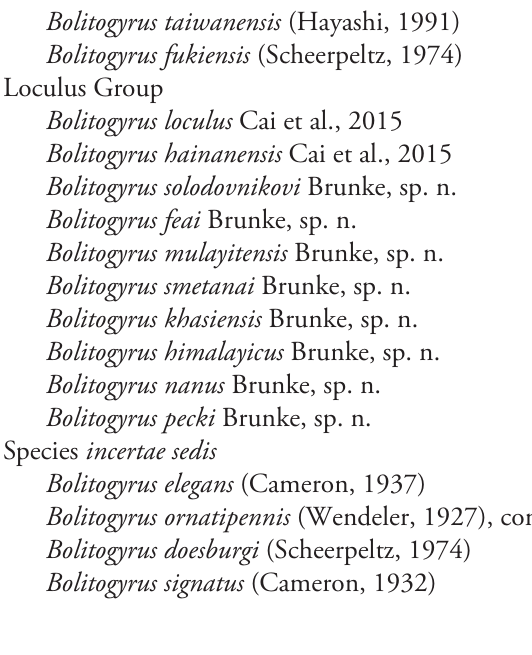
Key to the Oriental species of Bolitogyrus 1 Elytra without red, yellow or orange coloration (e.g., Fig. 1A–B); pronotum with two fine punctures in the dorsal row, anterior angles densely and deeply punctate, and sides of disc explanate laterally (Fig. 3B); prosternum with low, rounded, longitudinal ridge (Fig. 3D); China and northern portions of Myanmar, Laos and Thailand .......................................... Electus Group ... 2 – Elytra with yellow, red or orange coloration; pronotum with one puncture (marginal) in the dorsal row, anterior angles more sparsely punctate (Fig. 3A), if sides of disc explanate, then pronotum strongly transverse (male of one Sri Lankan species, Fig. 2H); pronotal margin often expanded (as in Fig. 1E, 3A); prosternum without ridge (Fig. 3C); southern China, India, Nepal, Myanmar and Southeast Asia .................................................................... 10 2 Abdomen bicolored red and black, elytra bright metallic green to blue (Fig. 1B) ............................................................................................... 3 – Abdomen entirely dark, elytra dark, with only faint metallic reflection (Fig. 1A) ............................................................................................... 4 3 Paramere with constricted stem, exposing median lobe in parameral view (Fig. 9E); apex of median lobe obtuse in parameral view (Fig. 9H); northeastern Sichuan , northern Chongqing and southern Shaanxi, China ......................... – Paramere vaguely constricted, not exposing median lobe in parameral view (Fig. 9A); apex of median lobe acute in parameral view (Fig. 9D);